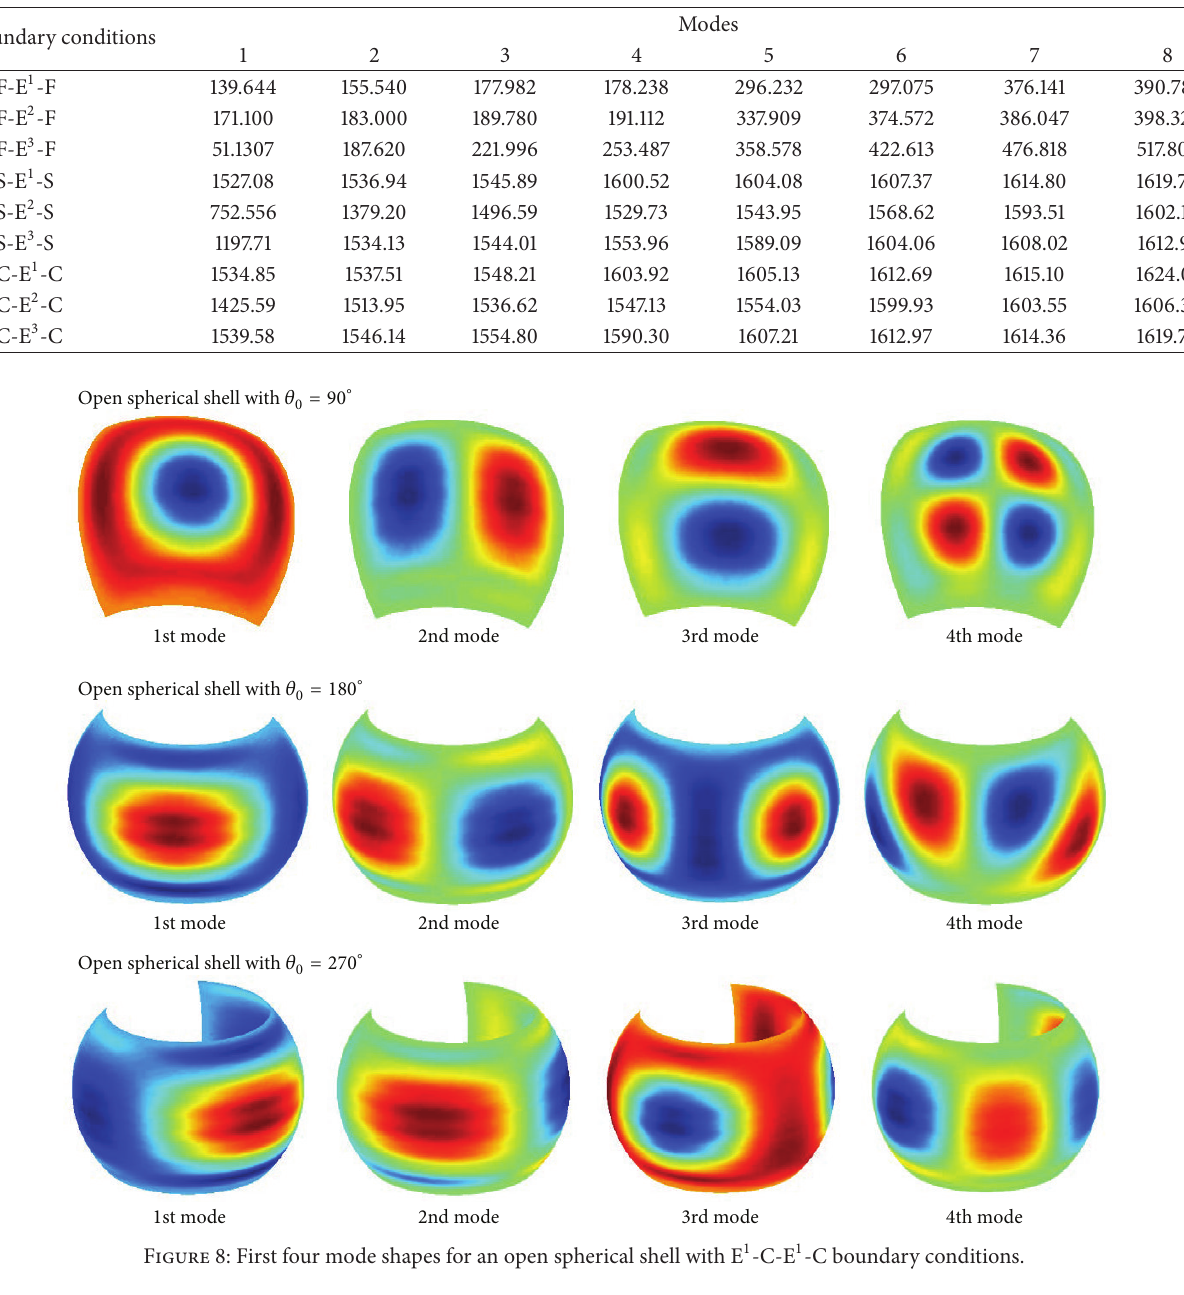
Table 13: First eight frequency parameters Ω = 𝜔𝐿 2 √𝜌ℎ/𝐷 for an open spherical shell subjected to various classical-elastic combined boundary conditions.